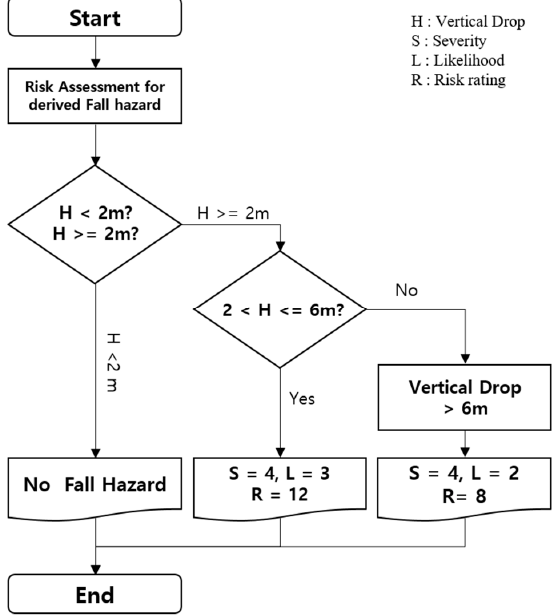
Figure 3. Algorithm of risk rating estimation by fall height.